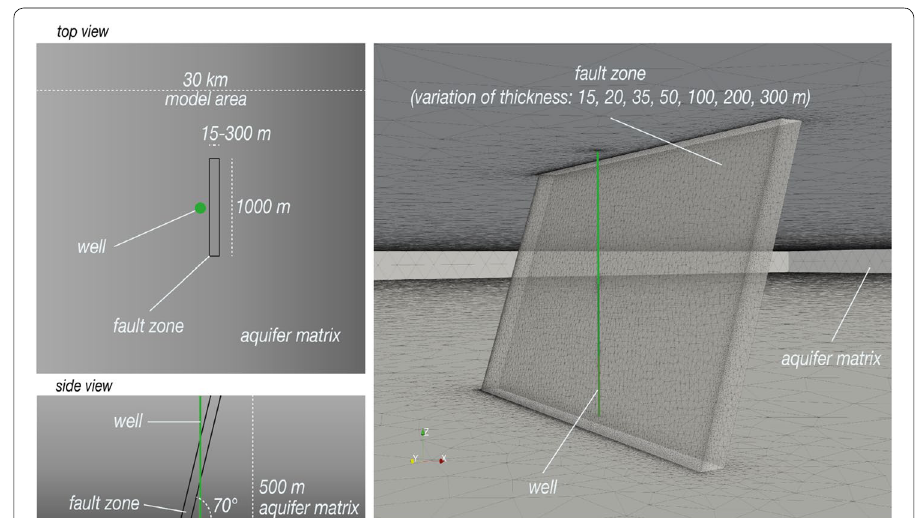
Fig. 3 Hydrogeological model (left) and unstructured tetrahedral mesh (right) for numerical simulation